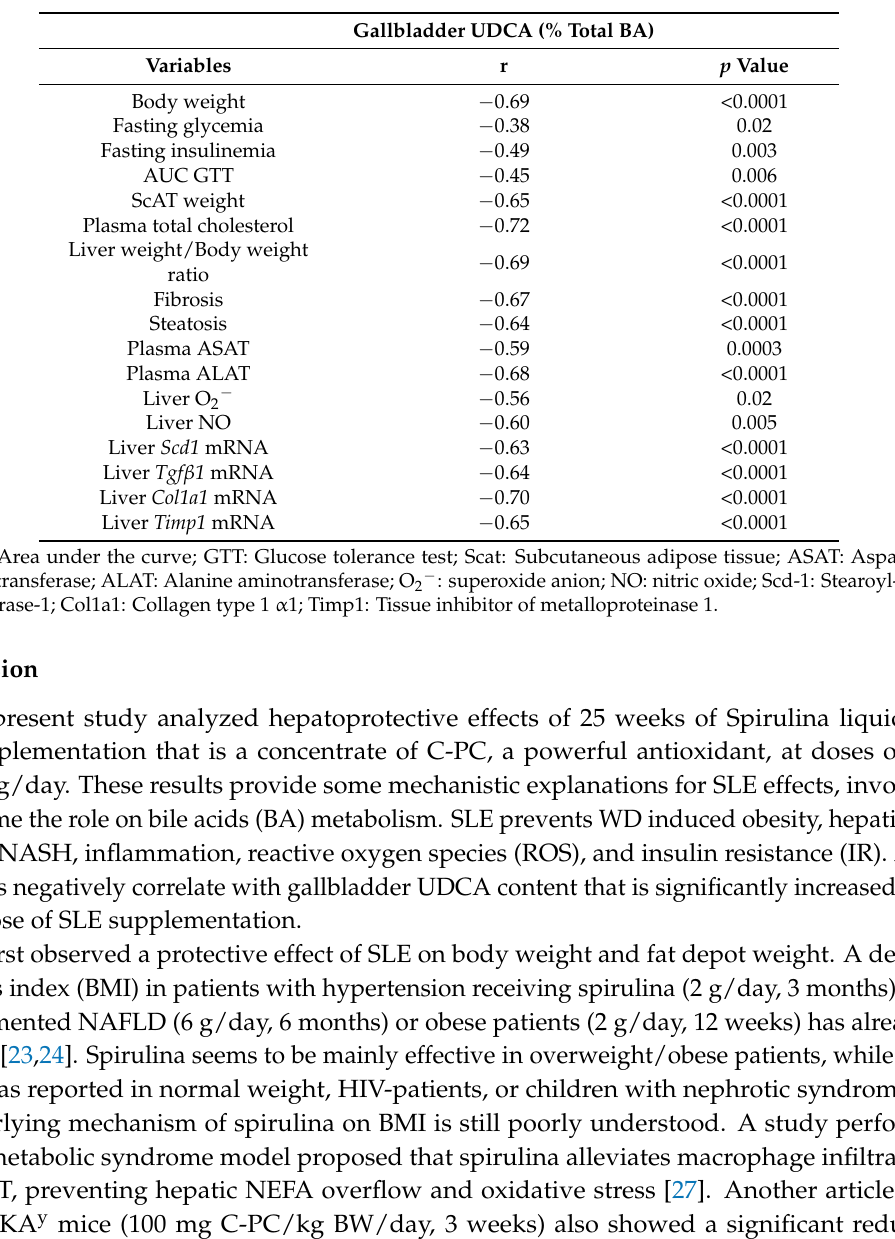
Table 3. Correlation between gallbladder UDCA content and biological variables in